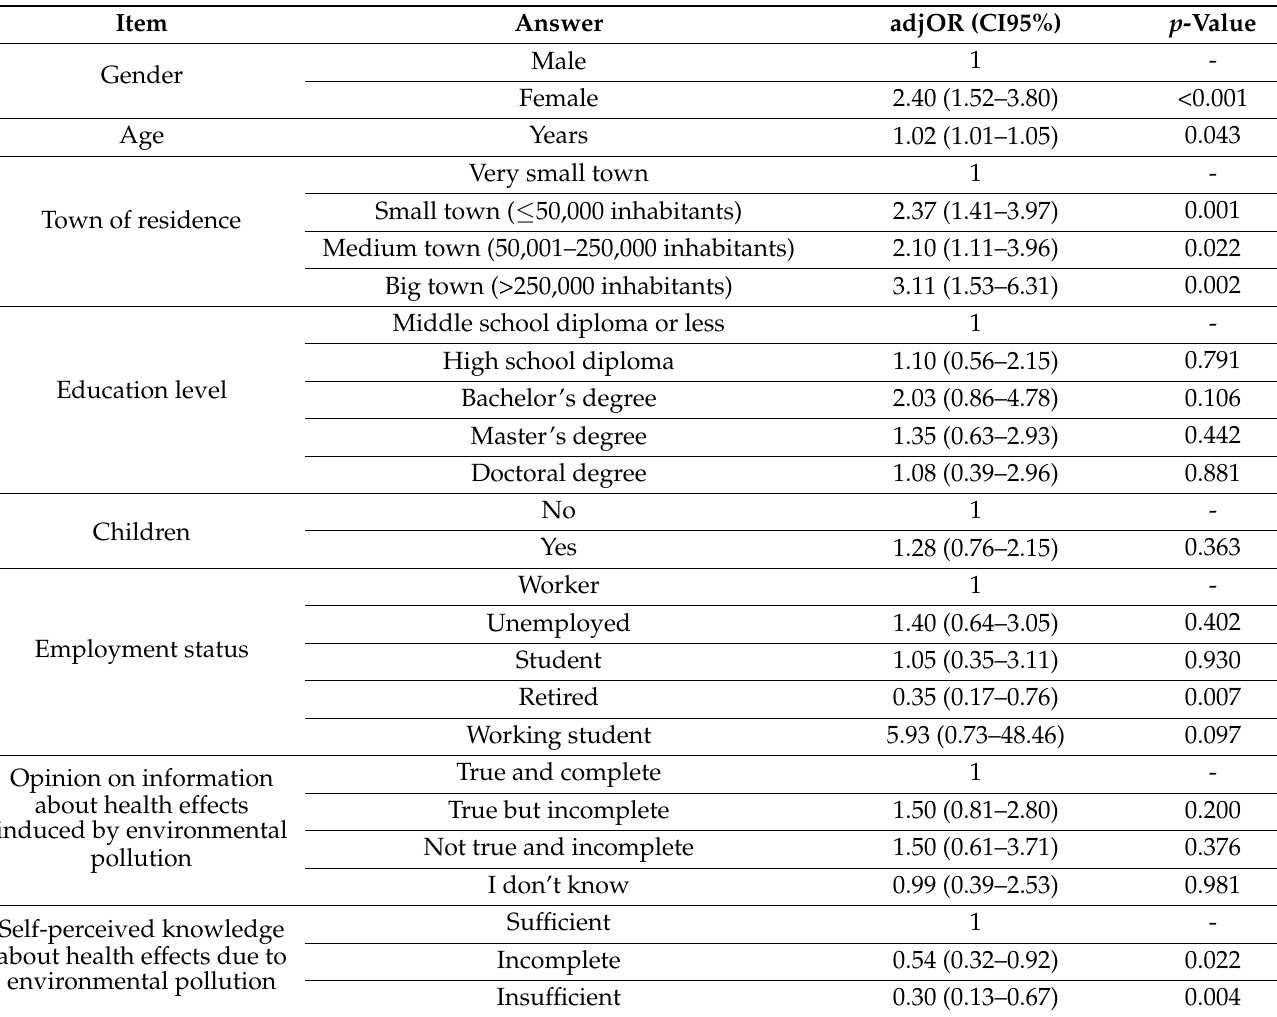
Table 2. Multivariable logistic regression model on the second outcome: self-perceived exposure to